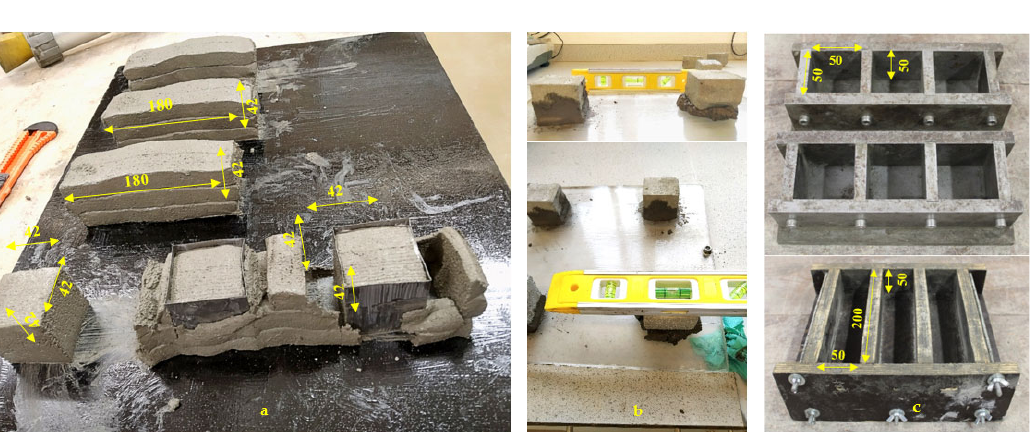
Figure 3. Sample preparation ( a ) for compressive and flexural strength measurement of printed members using the extruder, ( b ) preparing a flat surface for extruded samples for compressive strength test, and ( c ) moulds for preparing cast samples to test compressive and flexural strength.